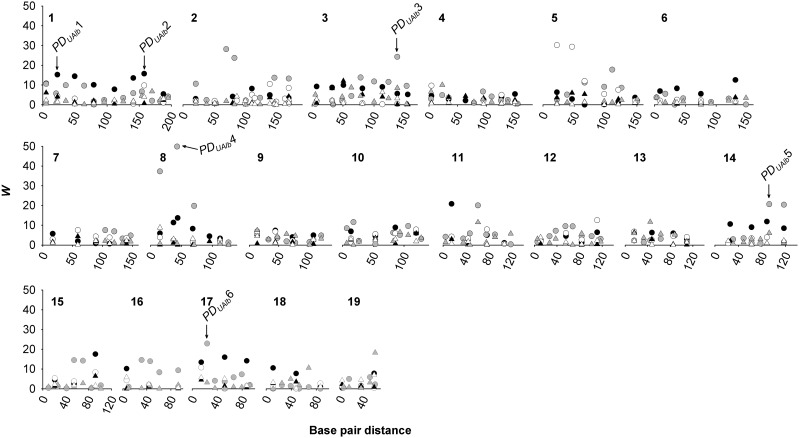
Association of phenotypic dispersion in urinary albumin (PDUAlb; circles) and urinary creatinine (PDUCrea; triangles) with marker genotype by chromosome in a) a cohort of 383 male F2 C57BL/6J × A/J house mice (Mus musculus) (Doorenbos et al. A) (solid symbols), b) a cohort of 207 male F2 C57BL/6J ApoE−/− × A/J mice (gray symbols) (Doorenbos et al. B) (Doorenbos et al. 2008) and c) a cohort of 340 male F2 DBA/2J × C57BL/6J mice (white symbols) (Sheehan et al. 2007). Significant points with maximal association with PDUAlb are indicated (i.e., ‘PDUAlb1’).